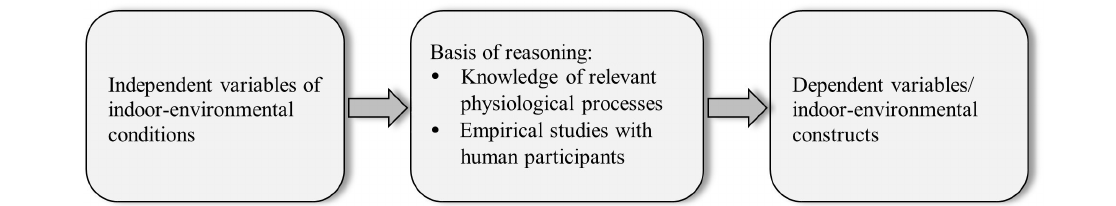
Figure 4. Illustrative schema of indoor-environmental comfort equation components.